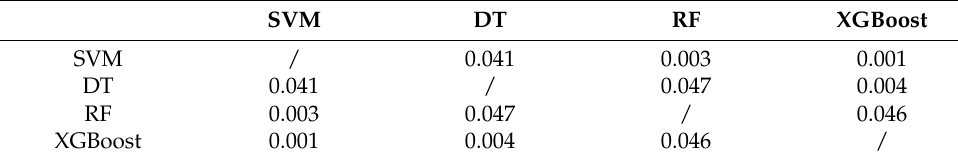
Table 13. P-value matrix for different prediction